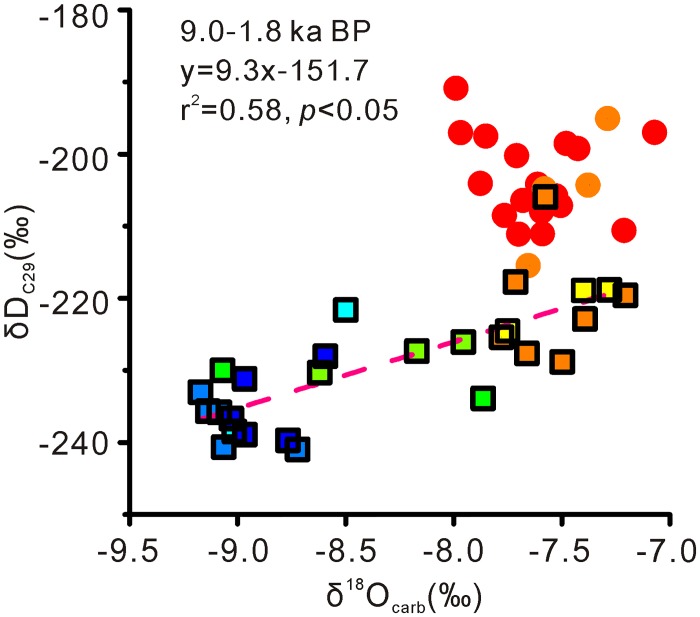
Correlation between δDC29 values of the SWGT peat core and δ18Ocarb values of Dongge Cave [30].Square, 9–1.8 ka BP; round, 1.8–0.3 ka BP. Symbol colors represent data age.